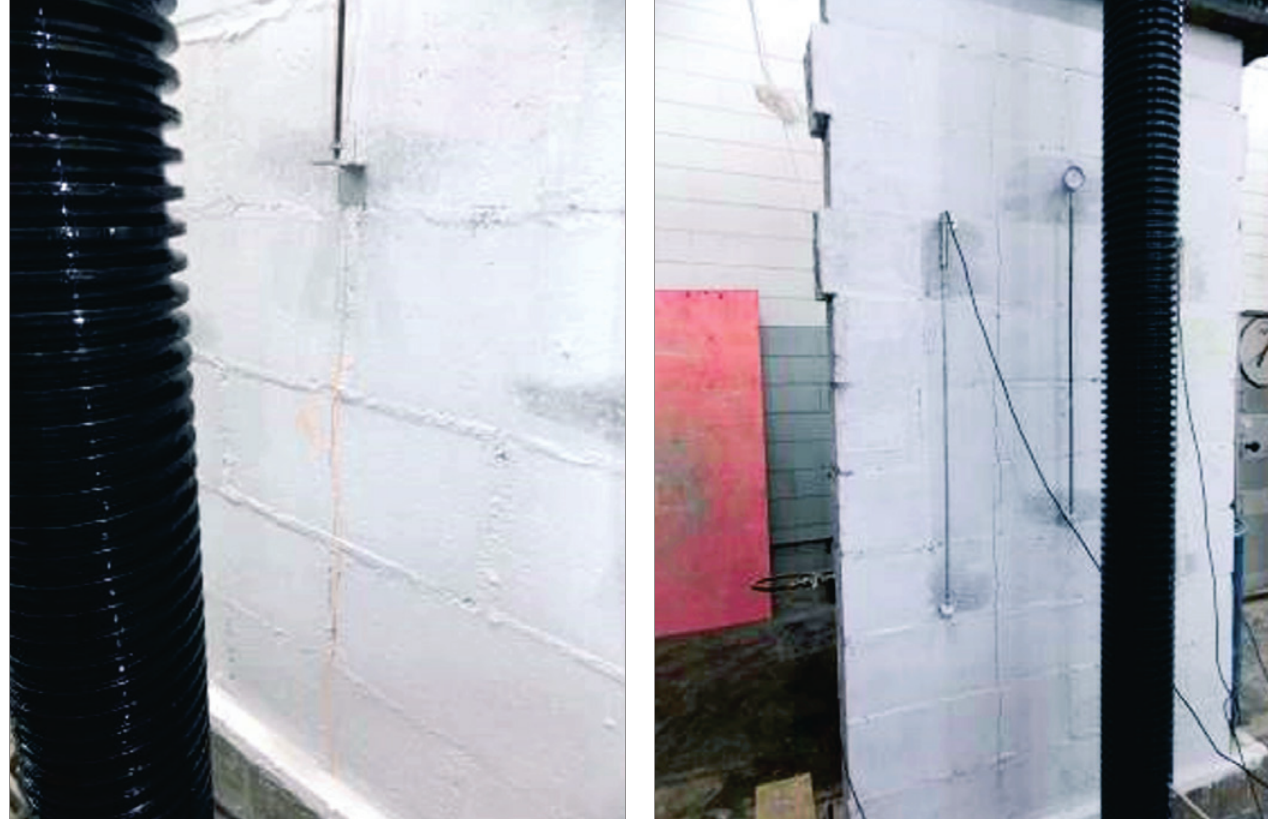
Modo de ruptura das paredes